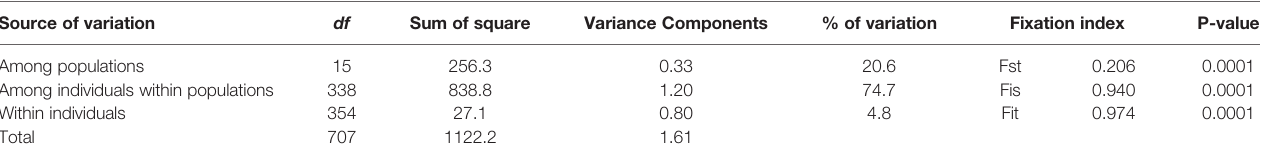
TABLE 2 | AMOVA summary shows that genetic variation is highest among individuals within populations, and that fi xation indices are all signi fi cant with a tendency toward genetic isolation.